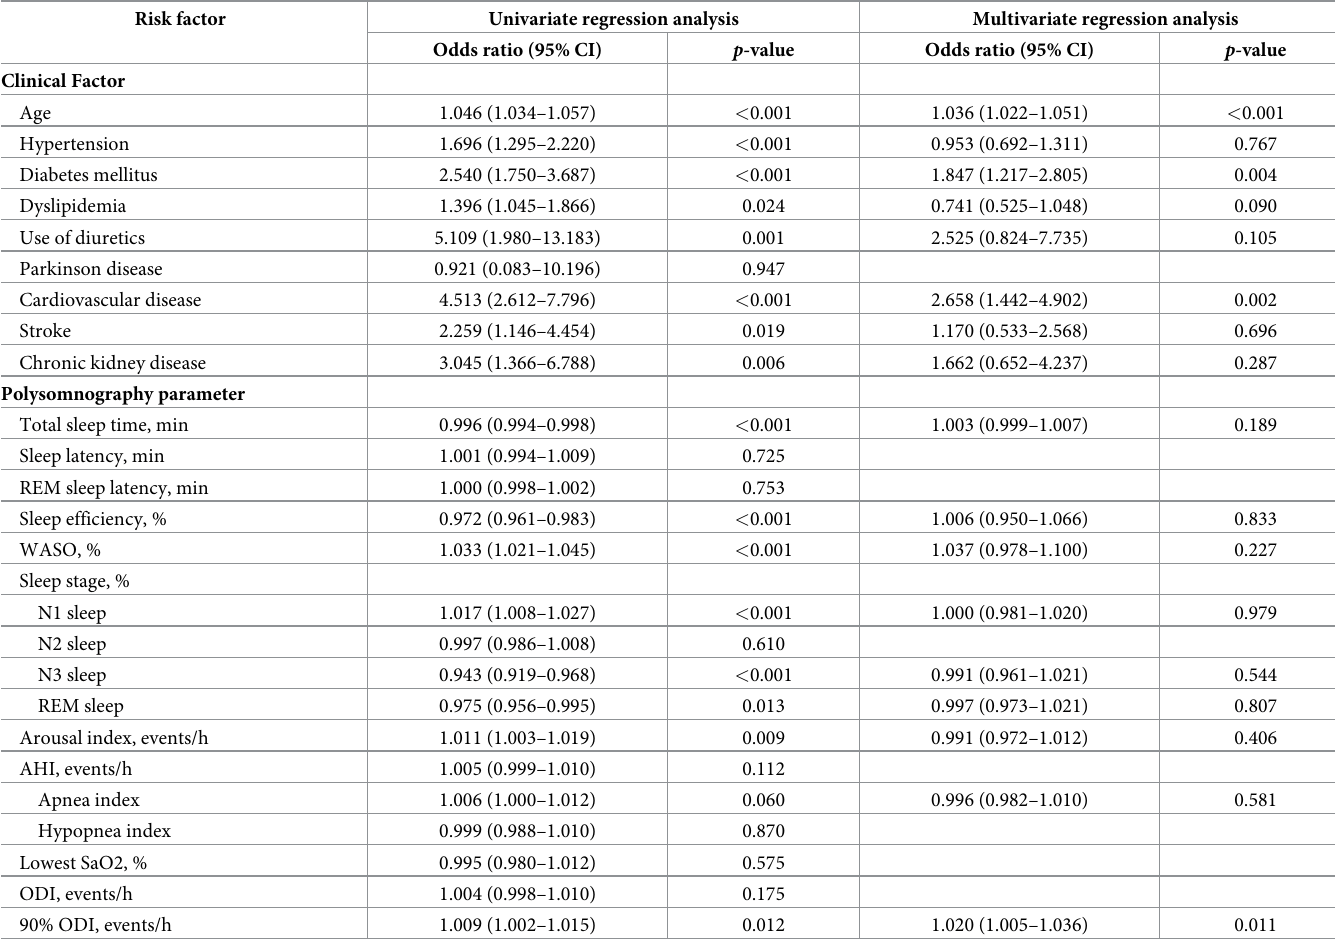
Table 3. Results of logistic regression analysis of factors related to nocturia in male participants with obstructive sleep apnea syndrome (N =